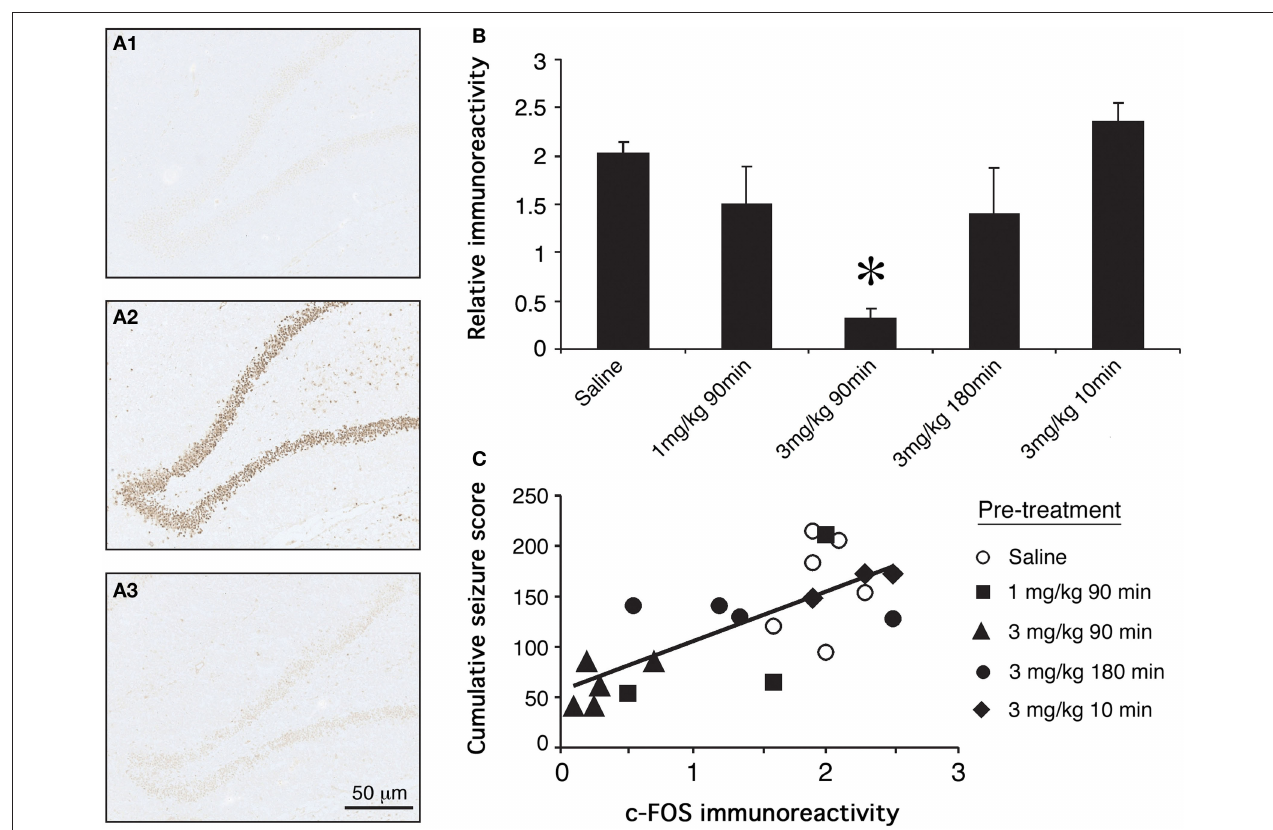
FIGurE 3 | Effects of GYKI 52466 preconditioning on KA-induced c-Fos expression in the dentate gyrus. (A) Representative micrographs of c-Fos immunoreactivity in the dentate gyri of (A1) saline treated controls; (A2) KA treated animals that received saline pre-treatment; (A3) KA treated animals that received 3 mg/kg GYKI 52466 90 min beforehand.